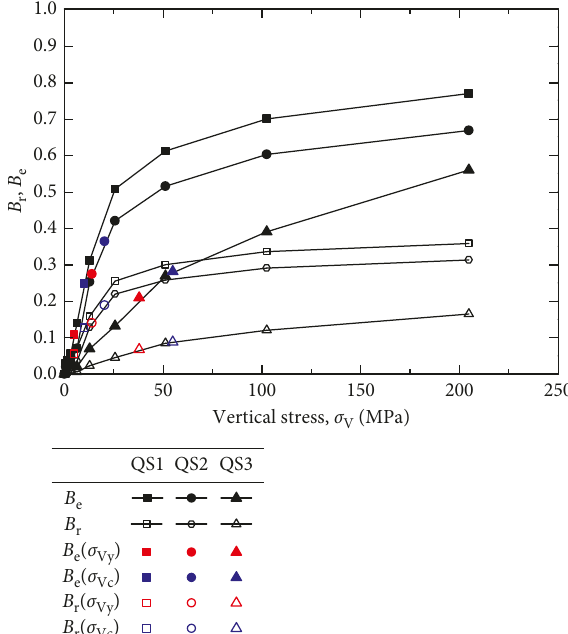
Figure 11: Relationship between σ